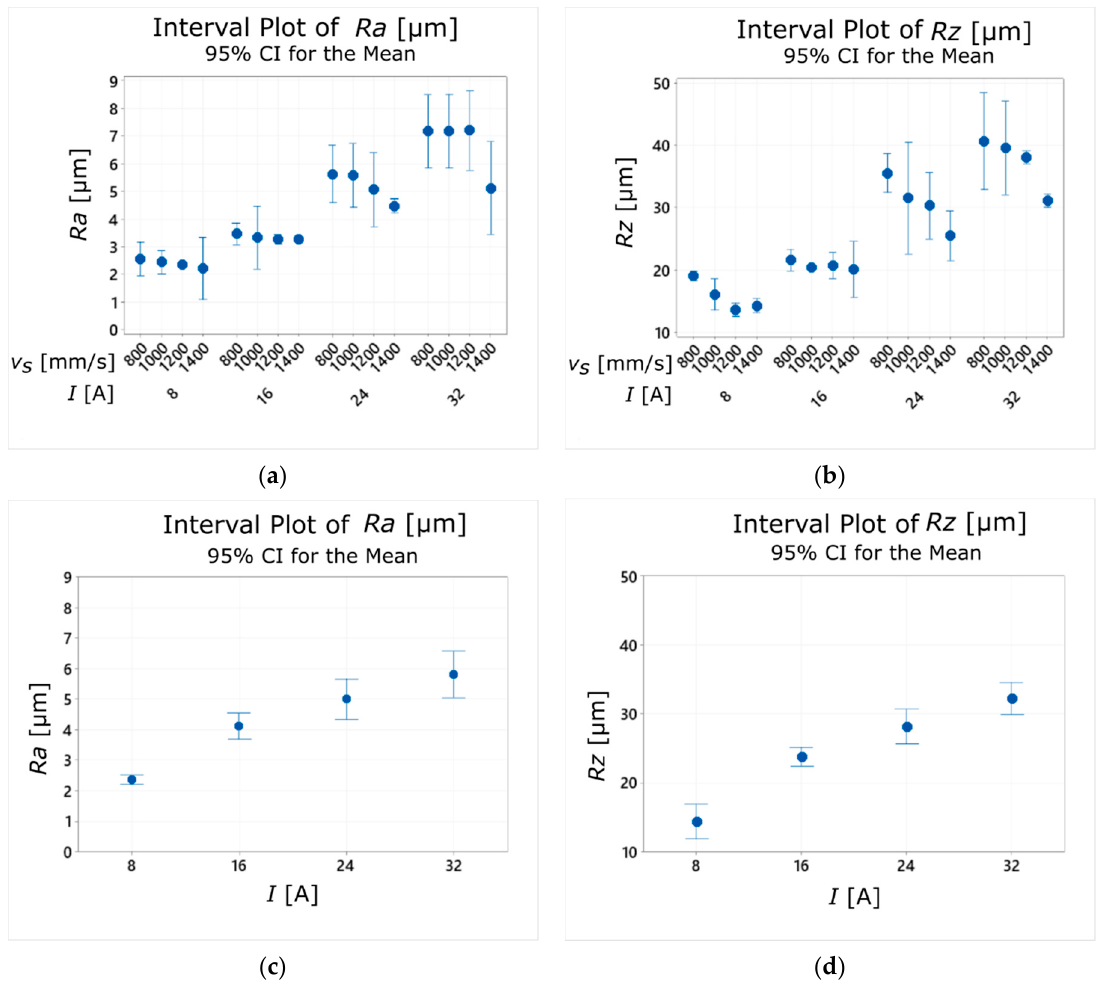
Figure 8. Relationship between input parameters ( I , v s ) and the average values of surface roughness parameters Ra and Rz for the sintered sample ( a , b ) and the cast sample ( c , d ).